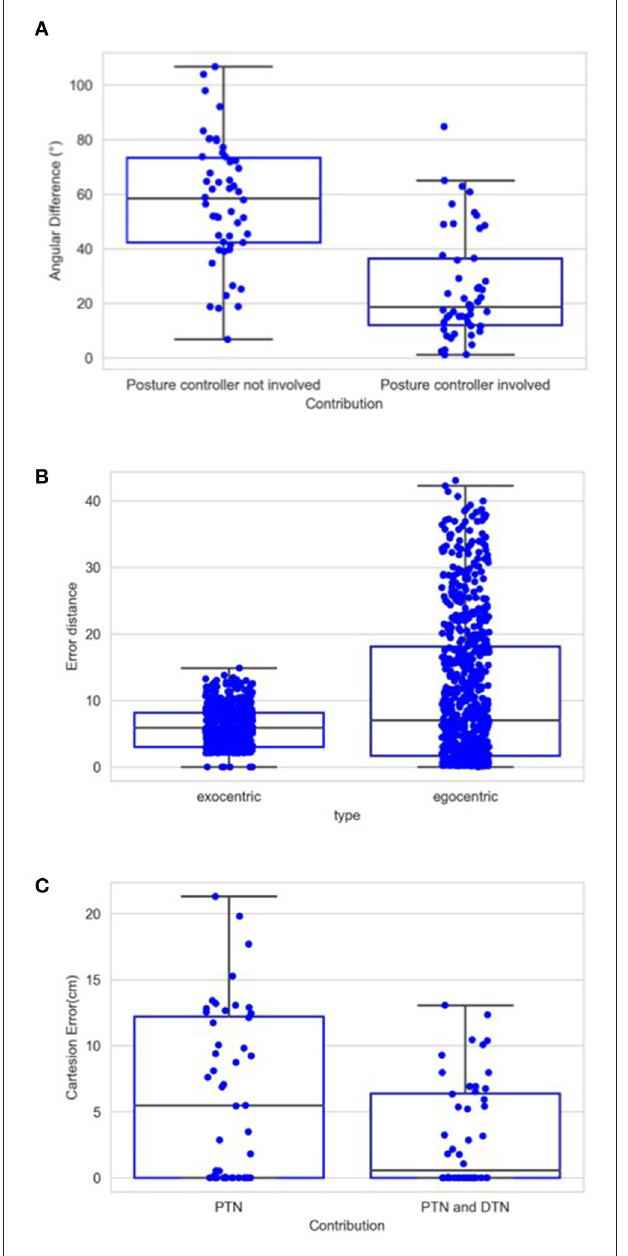
FIGURE 14 | (A) Average angular errors between palm and desired direction when trials are completed with and without the application of posture controller. Same as Figure 12 , each box in this chart summarizes five numbers. For the left box, these numbers are 106.69, 73.30, 58.36, 42.30, and 6.80 in degree from maximum to minimum, respectively, and 84.73, 36.31, 18.63, 12.06, and 1.16 for the right box. (B) Distance error in terms of the number of cells in the CPM. For the left box, these numbers are 43.04, 18.11, 7.04, 1.69, and 0 from maximum to minimum, respectively, and 14.86, 8.14, 5.87, 3.04, and 0 for the right box. (C) Cartesian errors when PTN worked only and when both PTN and DTN worked. Same as Figure 12 , each box in this chart summarizes five numbers. For the left box, these numbers are 21.29, 12.2, 5.46, 0, and 0 in cm from maximum to minimum, respectively, and 13.06, 6.39, 0.55, 0, and 0 for the right box.